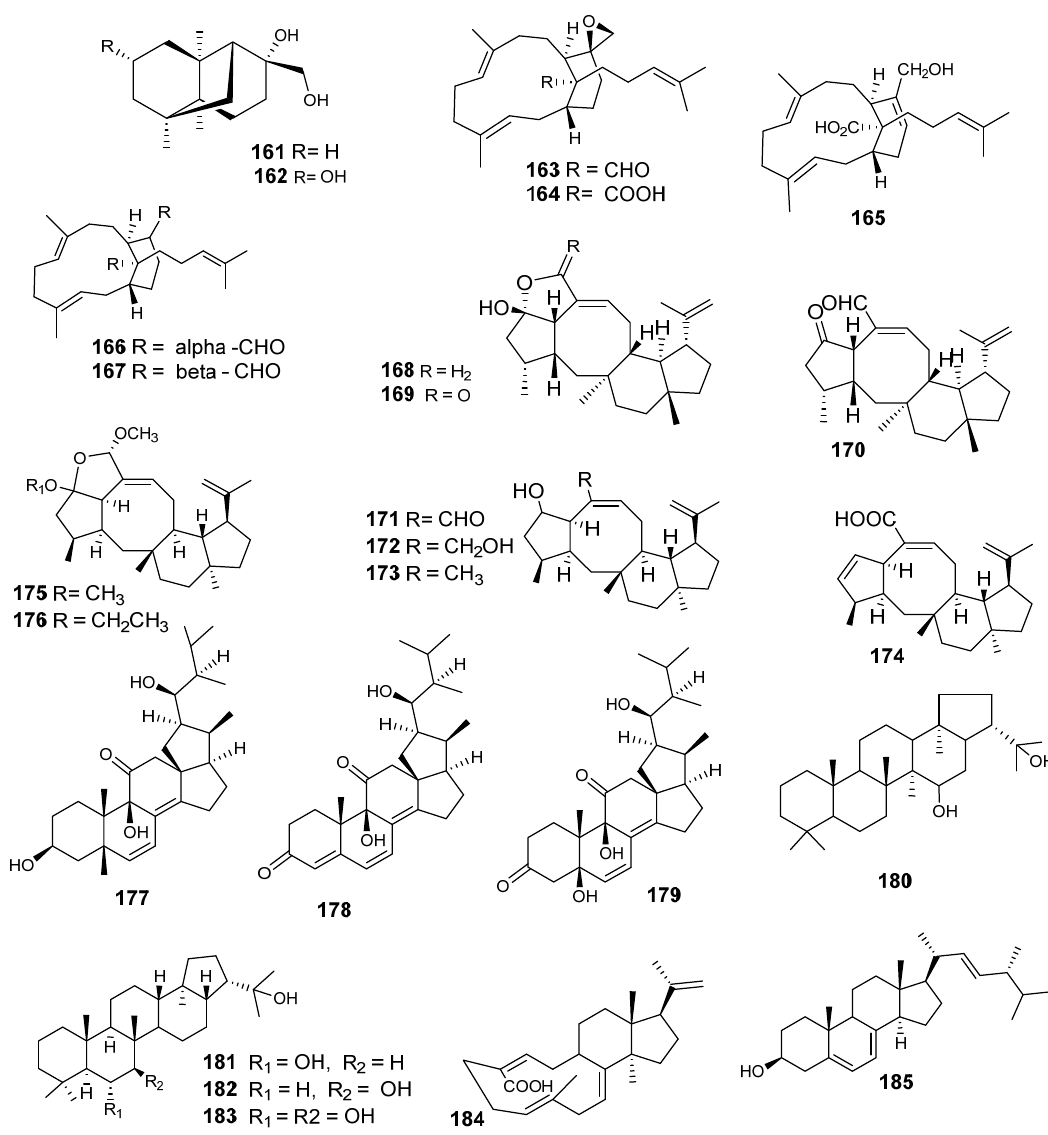
Figure 11. Structures of compounds 161–185.